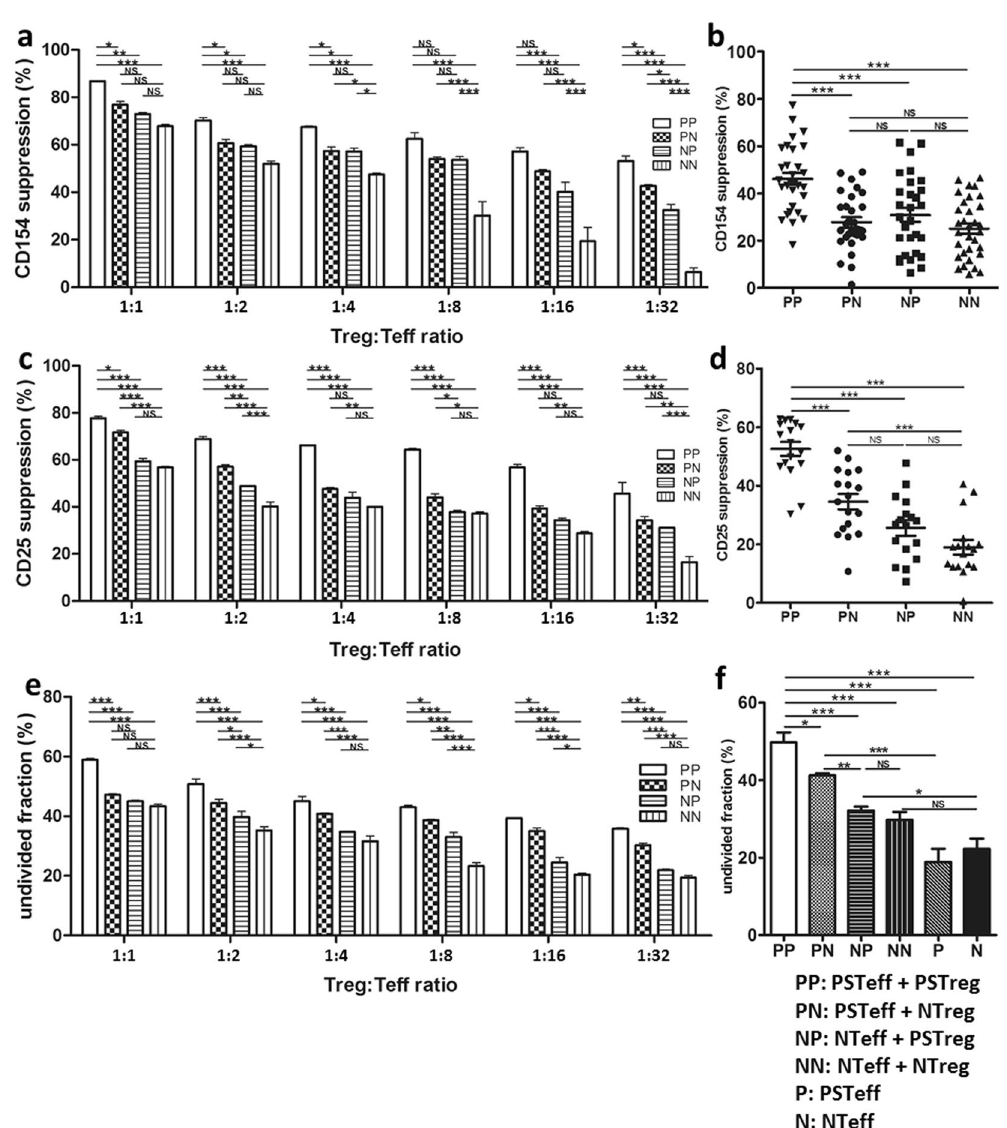
Figure 4. PSTreg show specific immunosuppressive activity. Three different assays were used to test PSTreg suppressive function towards PSTeff. PS/NTreg and PS/NTeff were seeded in 96 U-well plates with CD3/CD28 beads at different ratios, NTeff and PSTeff were set up as controls. Anti-CD154 and anti-CD25 were used to determine the Teff activation suppression, and CellTrace ™ CFSE Cell Proliferation Kit was used to determine the inhibition of Teff proliferation. ( a ) Suppression of CD154 after 7 h at different ratios. ( c ) Suppression of CD25 after 96 h. ( e ) Inhibition of Teff proliferation at different ratios. (n = 3). ( b ) Suppression of CD154 at ratio 1:1, ( d ) shows suppression of CD25 at ratio 1:1, Data represents 15 independent experiments from 8 donors and 10 independent experiments from 6 donors, respectively. ( f ) Inhibition of Teff proliferation at ratio 1:1, ( e ) Data represents 8 independent experiments from 5 donors. *** p < 0.001, ** p < 0.01, * p < 0.05. NS, not significant (p > 0.05). ANOVA with Bonferroni’s Multiple Comparison Test was used to determine the statistical significance. Error bars: